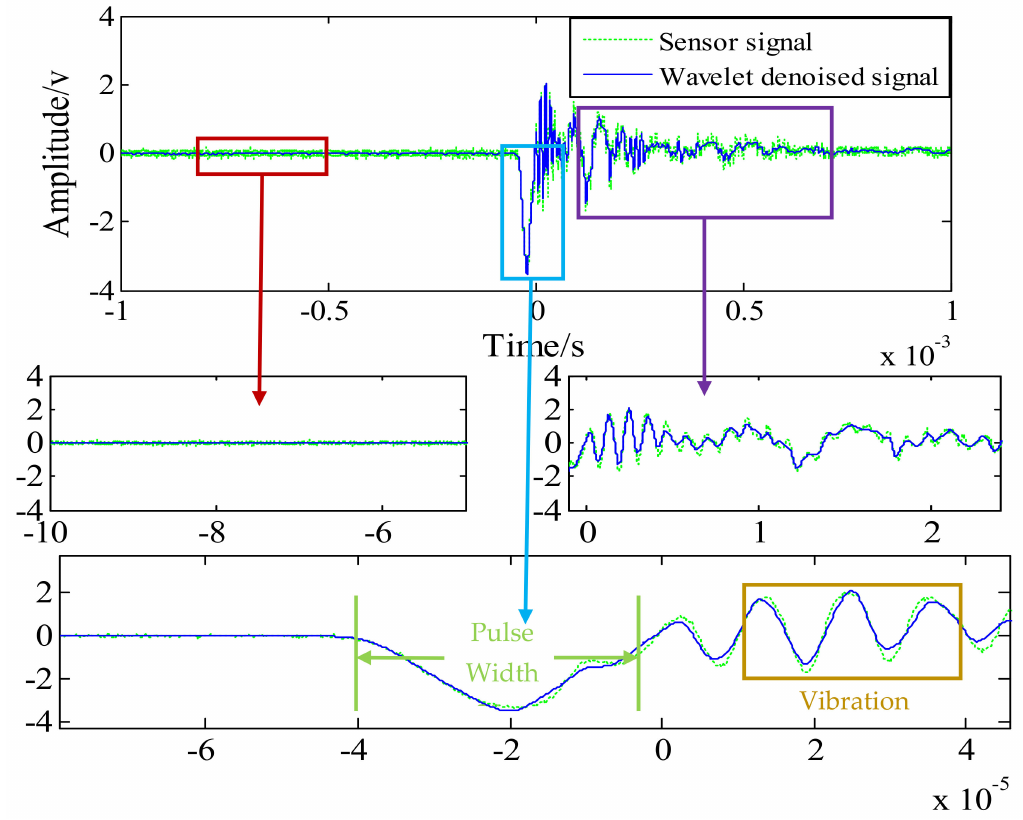
Figure 11. Test signal before and after wavelet threshold